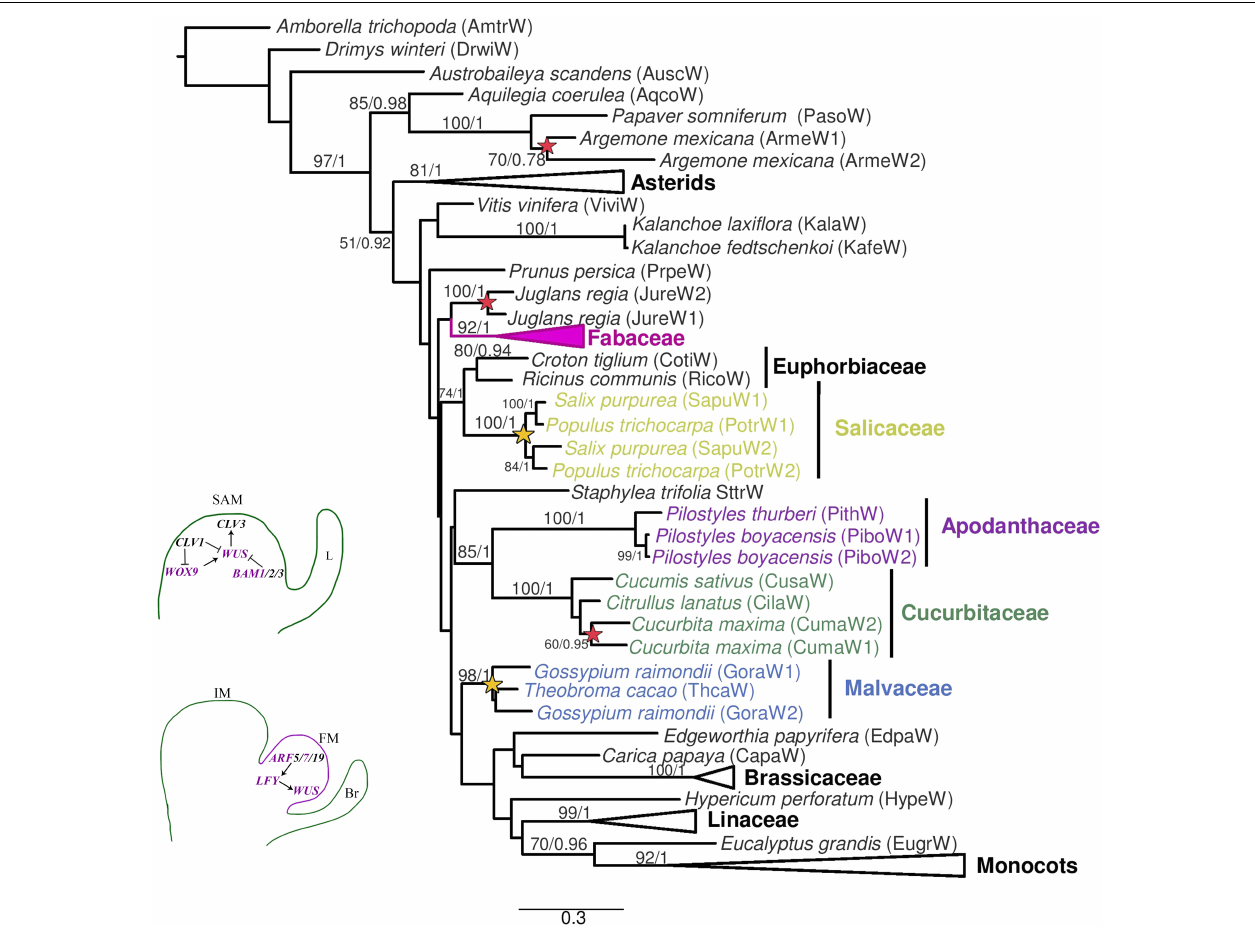
FIGURE 2 | Maximum likelihood reconstruction of the WUSCHEL gene lineage. Bootstrap values > 50 and posterior probability are shown above the nodes. Yellow stars and red stars indicate family level and species-specific duplication events, respectively. Bottom left, schematic representation of the canonical genes related to the SAM and the transition to IM and FM. Abbreviations : ARF, AUXIN RECEPTOR FACTOR; BAM, BARELY ANY MERISTEM; Br, bract; CLV, CLAVATA; L, leaf; LFY, LEAFY; WOX, WUSCHEL HOMEOBOX; WUS, WUSCHEL .